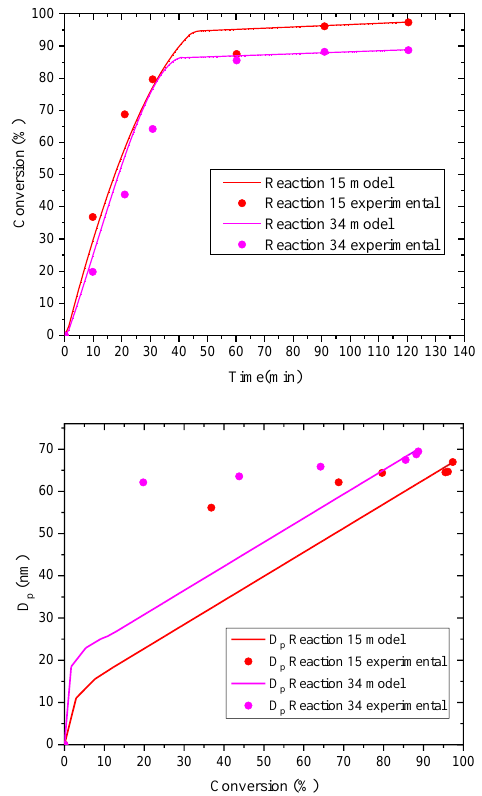
Figure 6. Comparison of simulation (POLYRED) and experimental data for monomer conversion vs. reaction time ( top ) and D p vs. monomer conversion ( bottom ) for experiments E15 and E34.